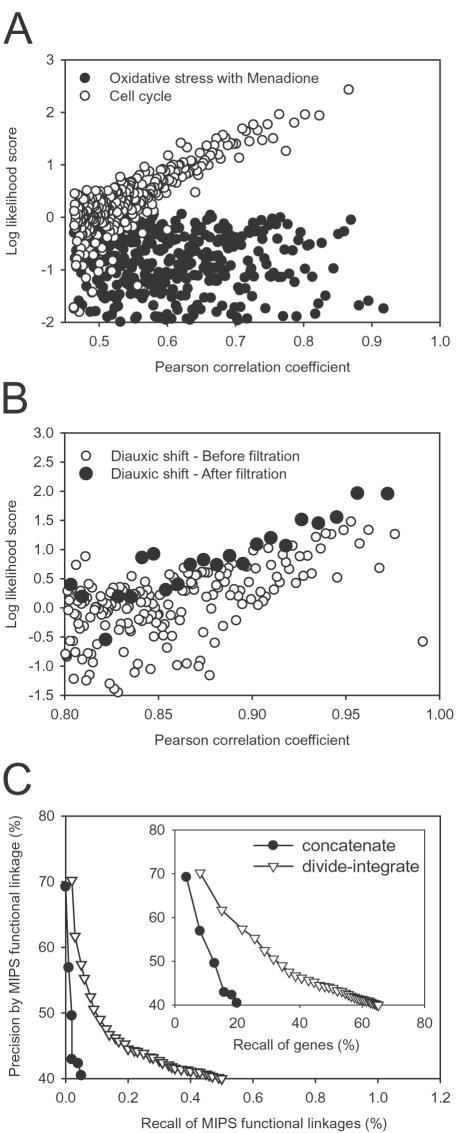
Optimizing the inference of linkages from mRNA co-expression.(A) Examples of a functionally informative DNA microarray data set and a non-informative one. Each set is illustrated as a scatter plot showing the log likelihood of functional association for each successive bin of 1,000 gene pairs (circles) ranked by decreasing Pearson correlation coefficient between expression vectors derived from that array set. The set of microarray data measuring oxidative stress responses following Menadione treatment [75] (filled circles) does not show a significant relationship between co-expression and the likelihood of functional association. In contrast, the set of cell cycle time course experiments [76] (open circles) shows a strong relationship. The effect of filtering genes using the parameters M and R is illustrated in (B). A data set of genes changing expression during the diauxic shift [77] (open circles) shows a noisy relationship between co-expression and the likelihood of functional association, especially for gene pairs with the highest Pearson correlation coefficients. However, by introducing the two threshold parameters, the relationship improves (filled circles), in particular decreasing variance considerably and improving the corresponding regression model. (C) The divide-test-integrate strategy [1] for inferring linkages, shown here calculated across all 500 microarray experiments (empty triangles) considerably outperforms analysis of the expression vectors constructed by concatenating the 500 experiments (filled circles). Precision is measured using reference linkages derived from MIPS functional annotation, masking the term “protein synthesis”, and recall is calculated for either reference linkages or total yeast genes (inset).